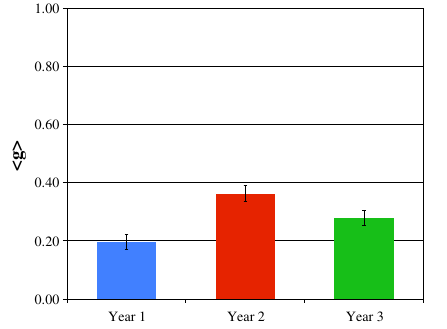
FIG. 2. FMCE normalized gain comparisons for school 1. Error bars are the standard error of the